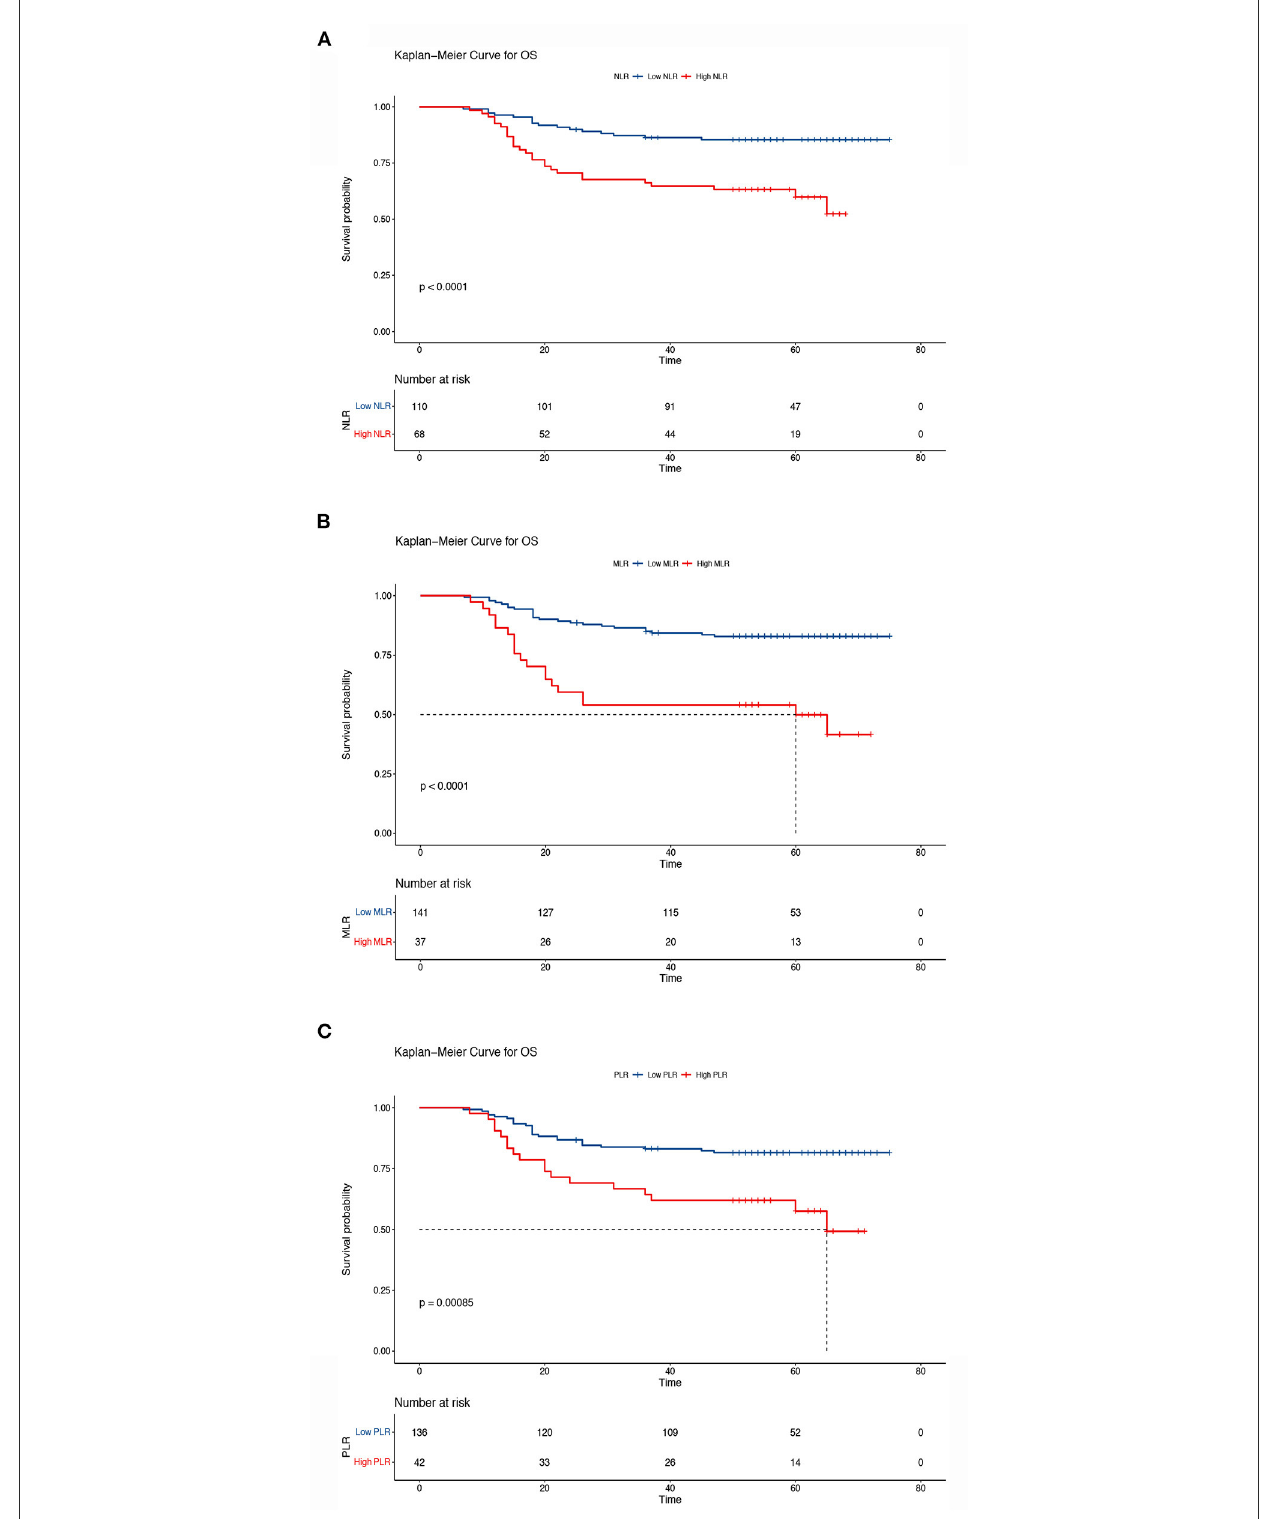
FIGURE5 Kaplan–Meier curves of overall survival according to the inflammatory indicators. (A) Low neutrocyte/lymphocyte ratio (NLR) vs. high NLR (low NLR: ≤ 2.8, high NLR: > 2.8), (B) low monocyte/lymphocyte ratio (MLR) vs. high MLR (low MLR: ≤ 0.41, high MLR: > 0.41), and (C) low platelet lymphocyte ratio (PLR) vs. high PLR (low PLR: ≤ 186.67, high PLR: > 186.67). The Kaplan–Meier method was used to calculate the survival rate, and the log-rank test was used to compare survival distributions between the